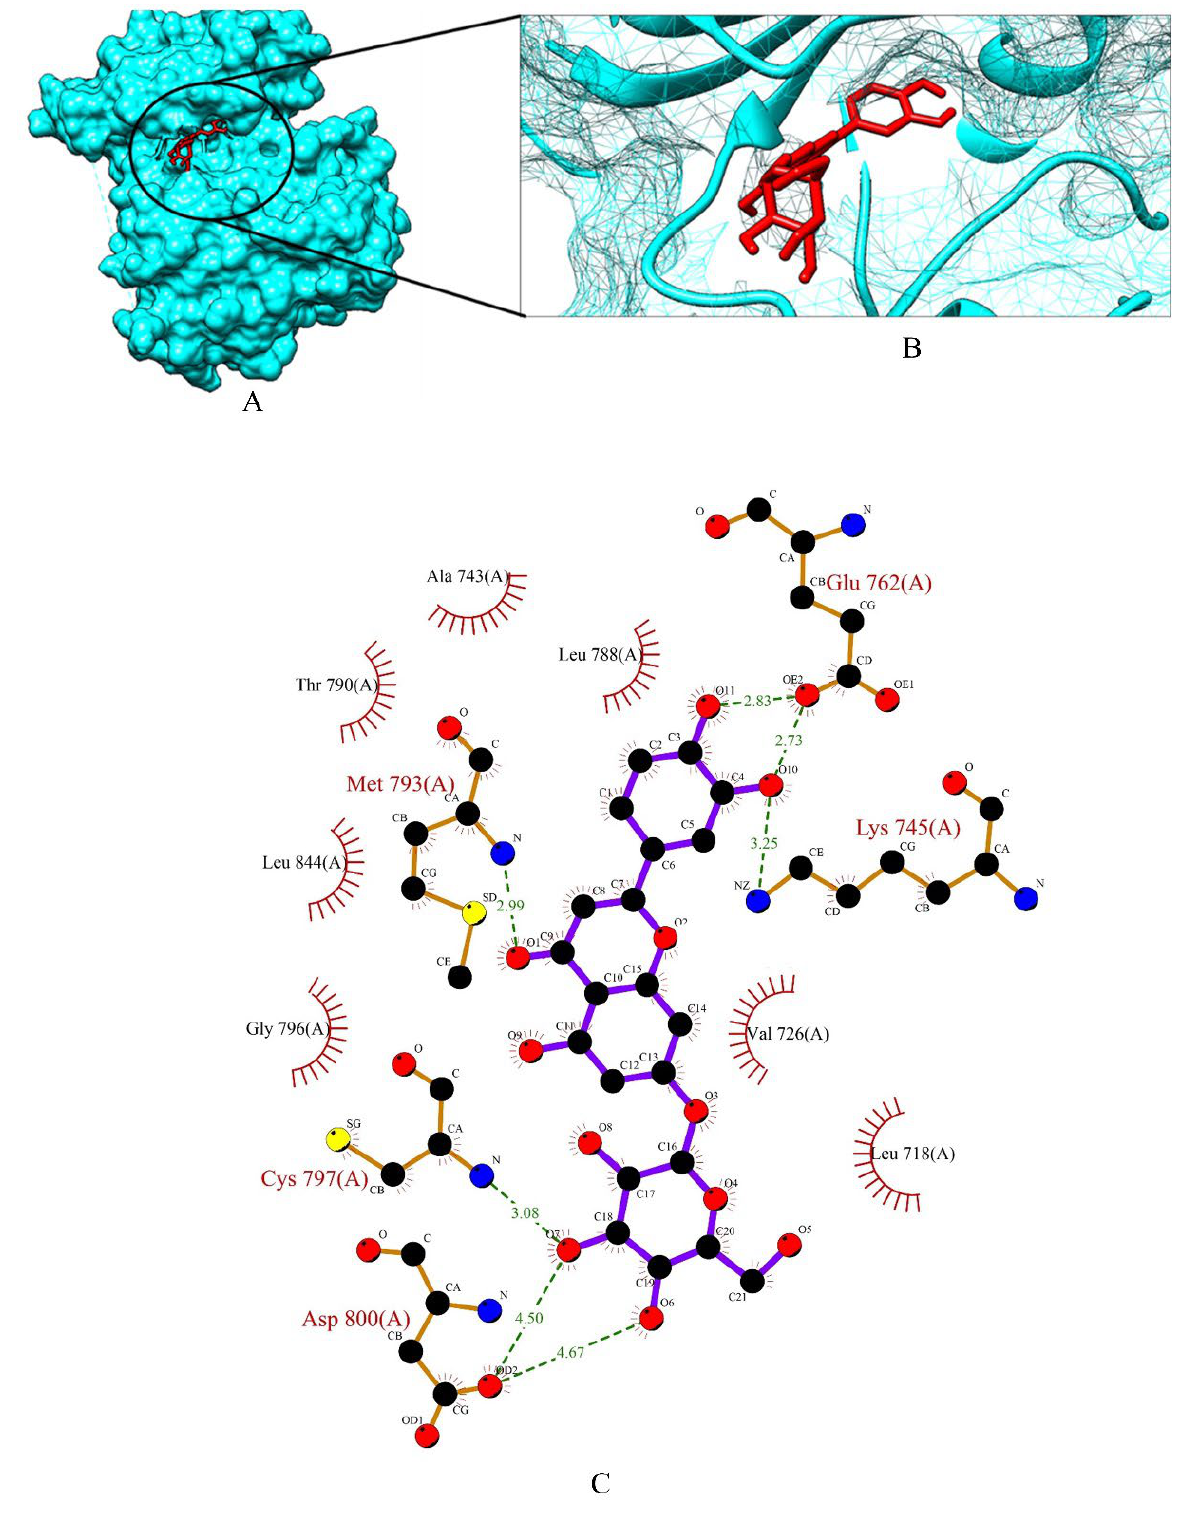
Figure 11. ( A ) Surface view of cynaroside-EGFR binding complex. ( B ) Binding pose of cynaroside. ( C ) Visualization of the docked complex with ligplot + shows the binding interaction of cynaroside with EGFR. Seven hydrogen bond interactions (green dotted lines) were formed between cynaroside and four amino acid residues (Lys 745, Glu 762, Met 793, Cys 979, Asp 800) of target protein EGFR.